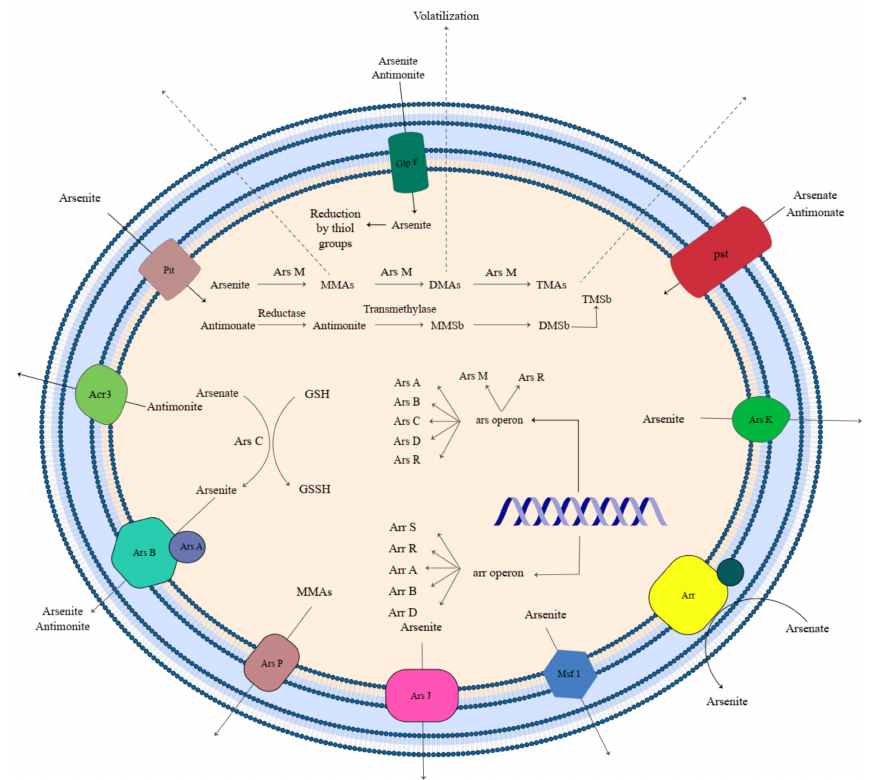
Figure 2. Arsenic and antimony transporters and remediation mechanisms in bacteria (Although this microorganism is shown as a Gram-negative bacterium, transporters and mechanisms belong to different species of Gram-positive and Gram-negative bacteria).